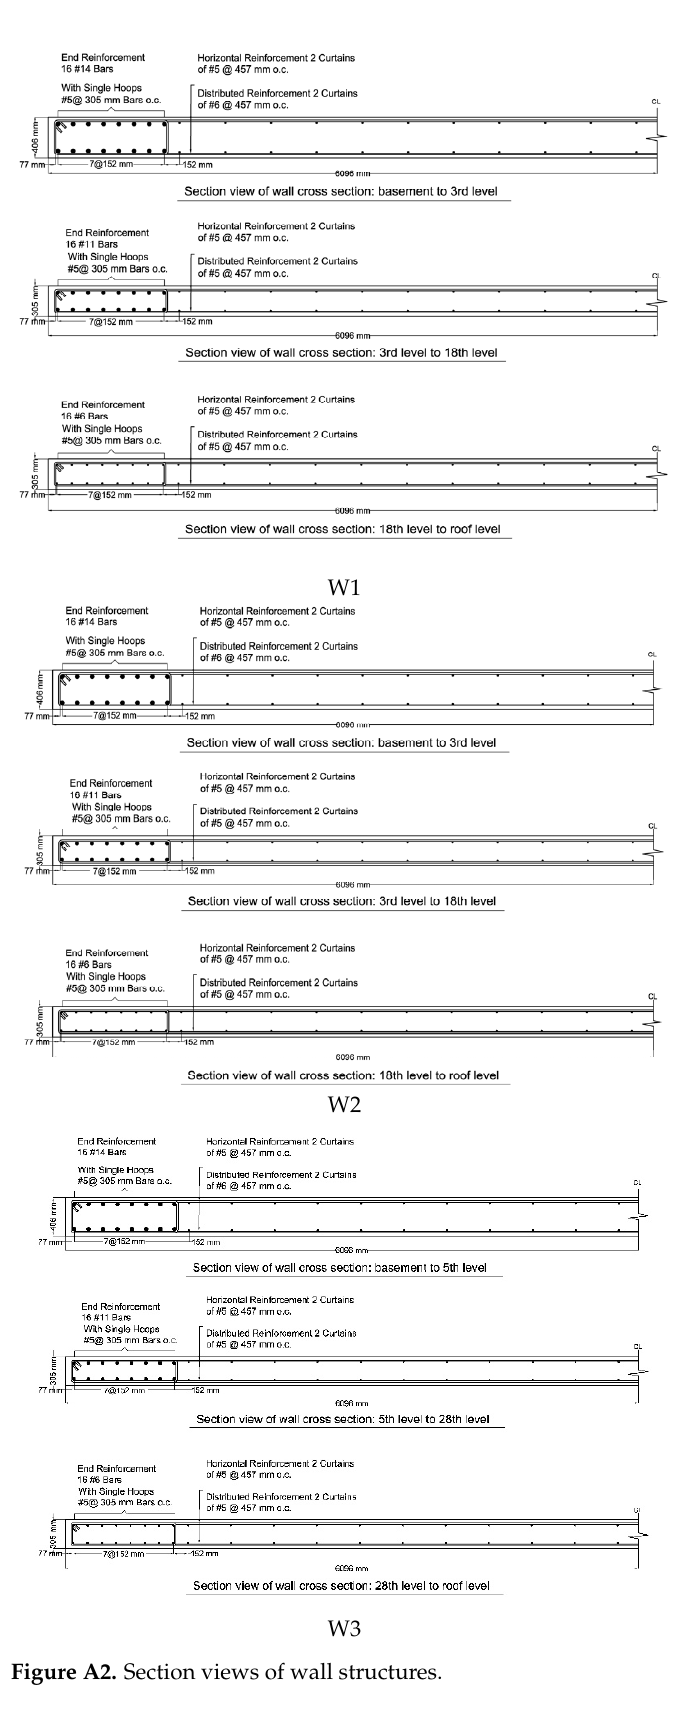
Figure A2. Section views of wall structures.